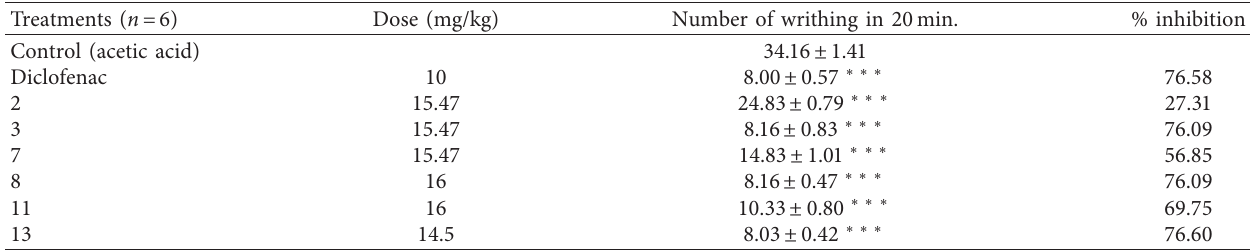
Table 3: Analgesic activity of compounds by acetic acid-induced.